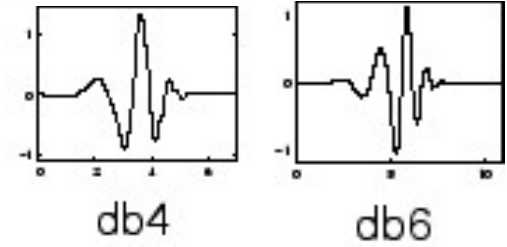
Figure 7. Wavelets used in analyses Daubechies 4 (db4); and Daubechies 6 (db6) [37].